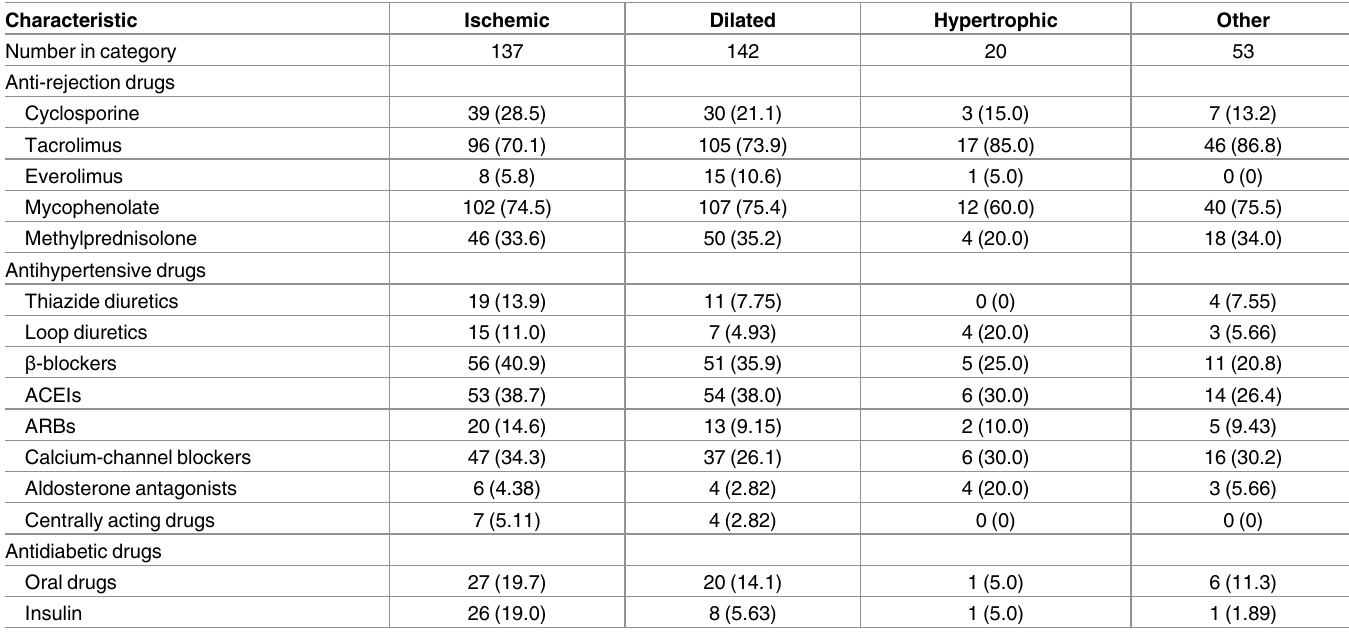
Table 4. Medication use by type of